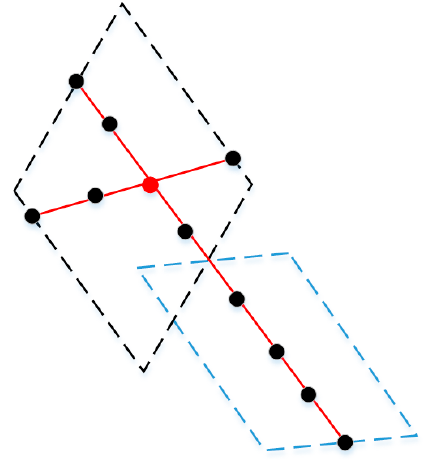
Figure 4. Points on CLE may not be on a plane.